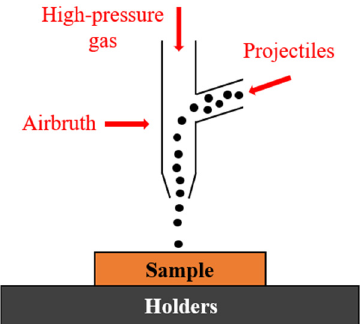
Figure 1. Schematic illustration of HESP process.